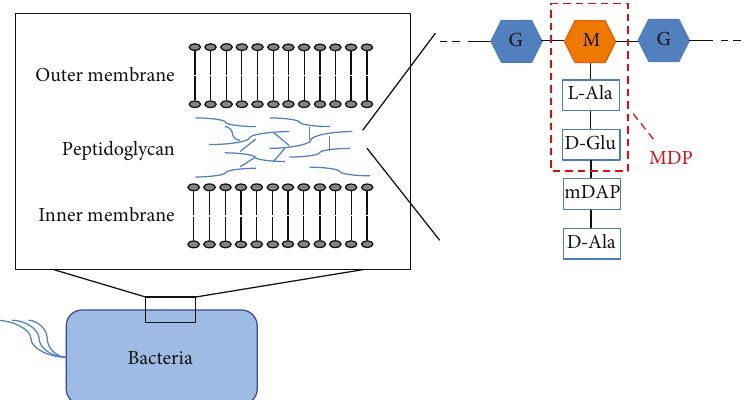
Figure 1: Schematic structure of peptidoglycan and MDP. PGN, a major component of the bacterial cell membrane, is a crystal lattice structure formed by the combination of linear chains of two alternating amino sugars, GlcNAc and MurNAc. MDP consists of MurNAc and two amino acids, L -Ala and D -Glu. M: MurNAc; G: